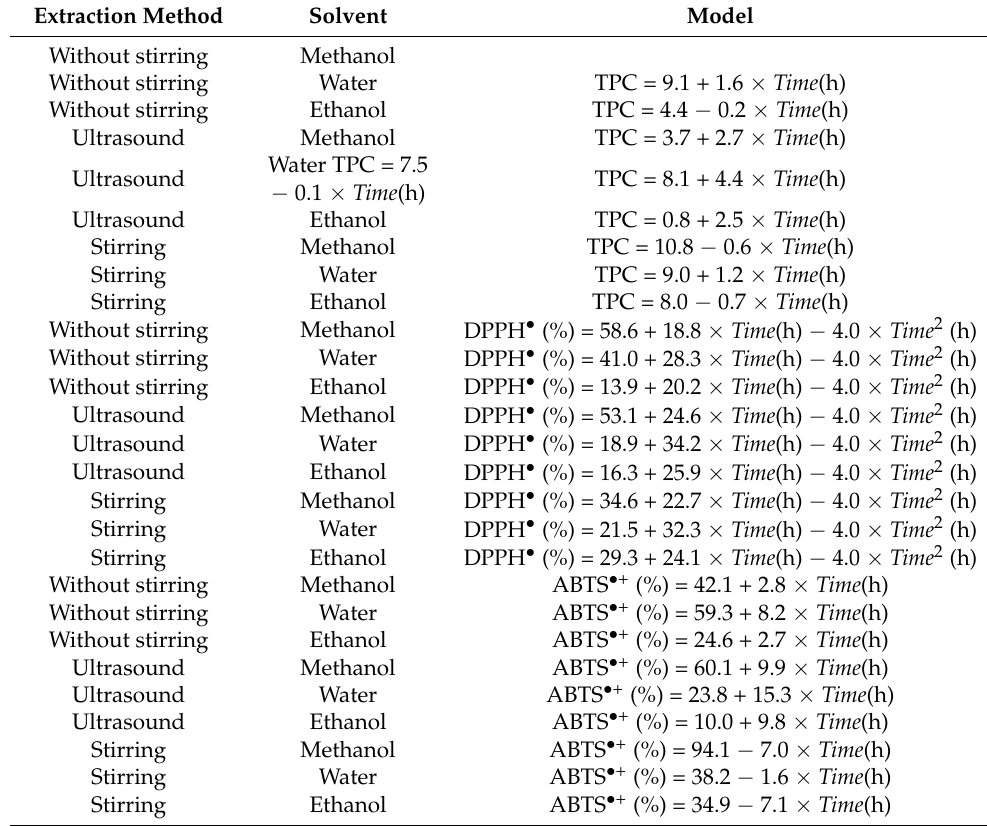
Table 3. Mathematical models for the prediction of total phenolic content (TPC, mg eq gal- lic acid/g dried nettle), %DPPH • (1,1-diphenyl-2-picrylhydrazyl) and %ABTS • + (2,2-azino-bis(3- etilbenzotiazolin)-6-sulfonic acid) values as a function of extraction time, for each method and solvent